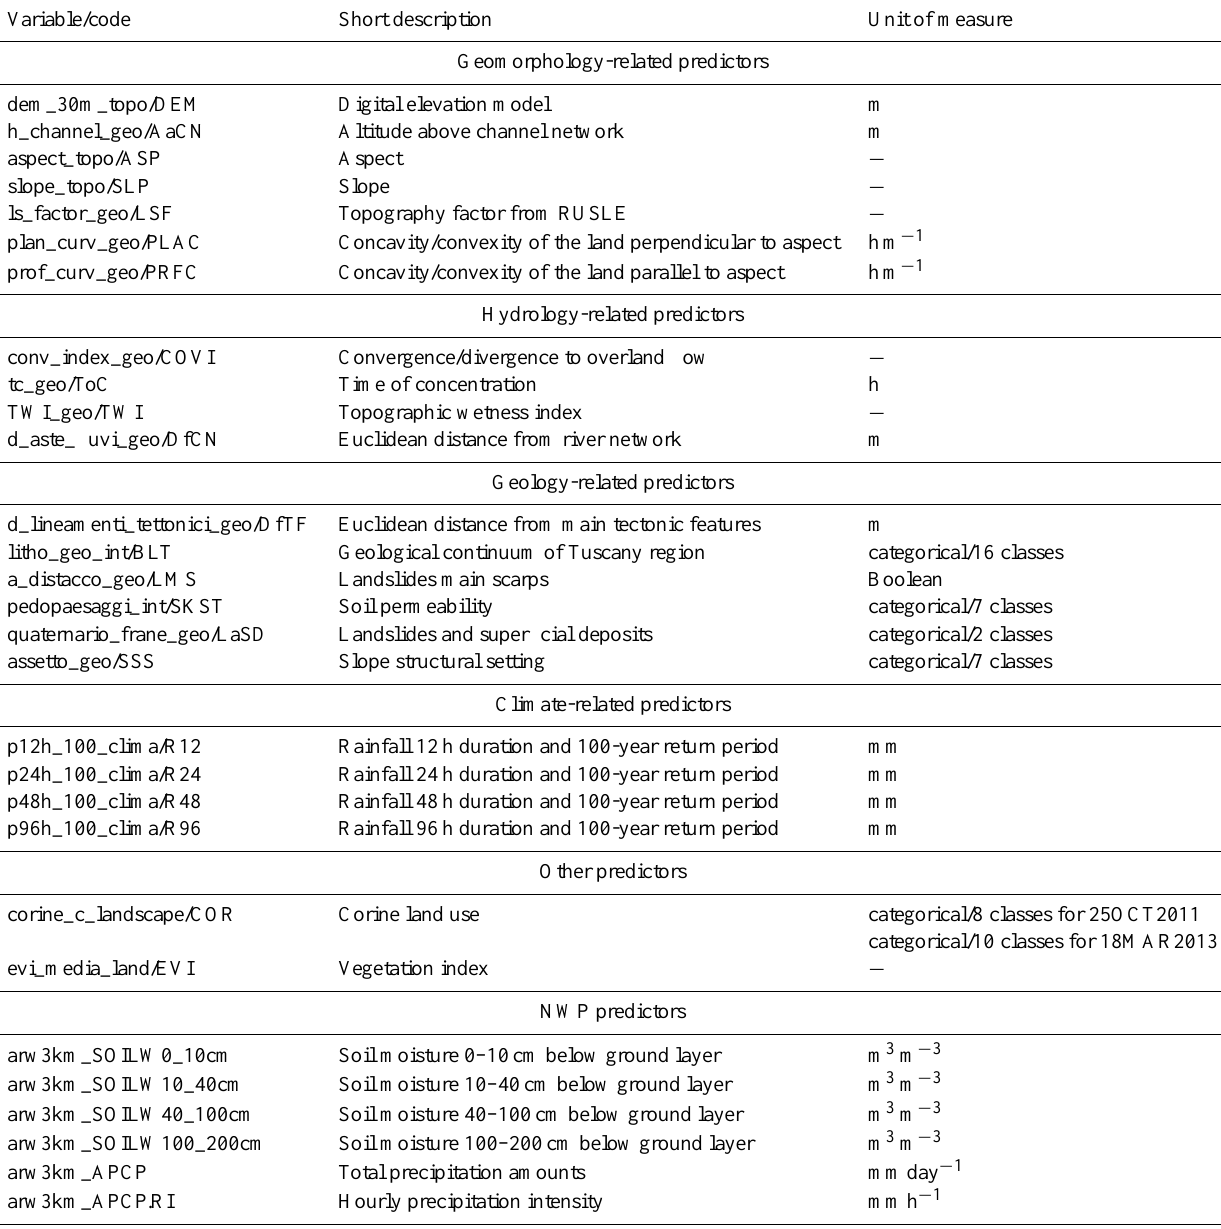
Table 1. List of the predictors taken into account in both GLM and RF classifier for landslide hazard mapping. Variable/code Short description Unit of